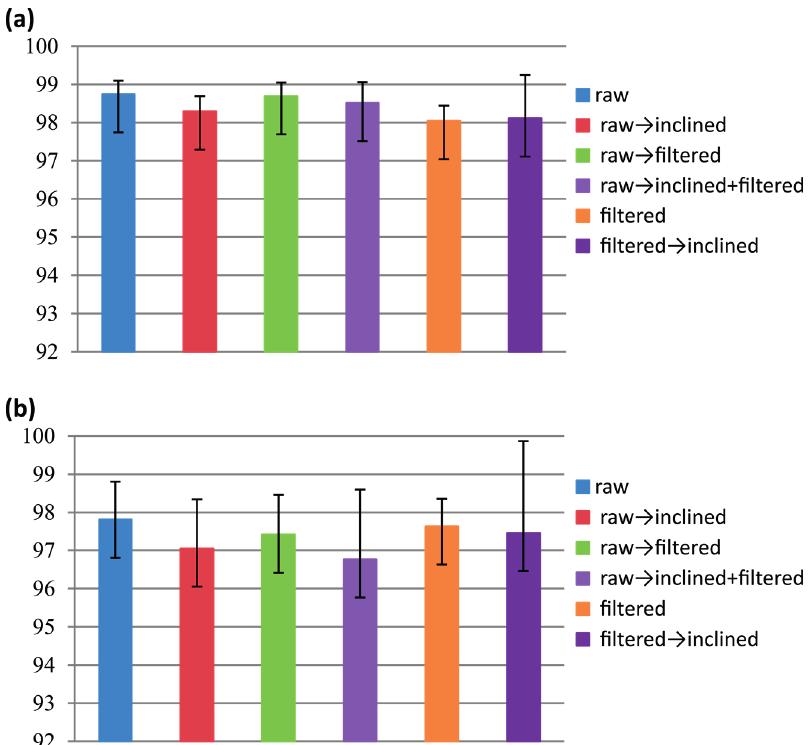
Figure 6. Average classification accuracy over; ( a ) first dataset; ( b ) second dataset.